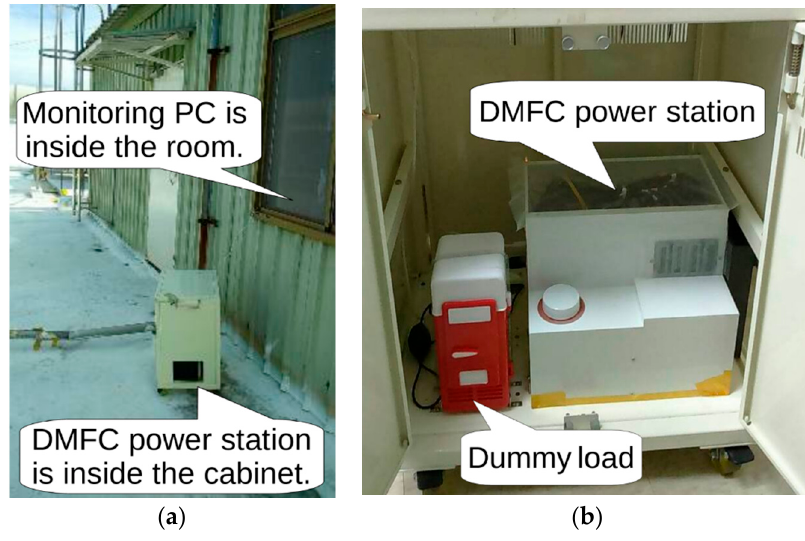
Figure 7. DMFC power station experiment setup. ( a ) Outside view; ( b ) inside view.